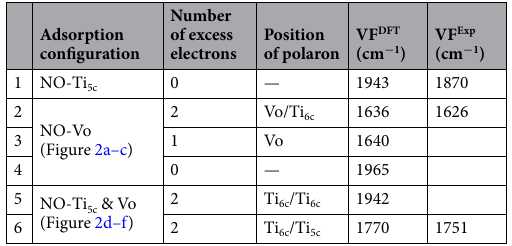
Table 1. Calculated vibrational frequency of adsorbed NO on TiO 2 (110) and their dependence on the location of polarons. The experimental values are also listed in the last column for comparison.